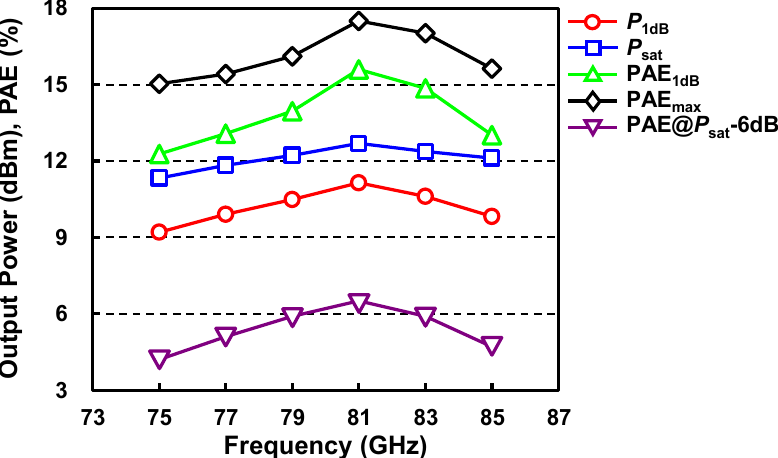
Figure 11. Measurement results of P 1dB , P sat , PAE 1dB , PAE max and PAE@ P sat -6 dB over 75–85 GHz.